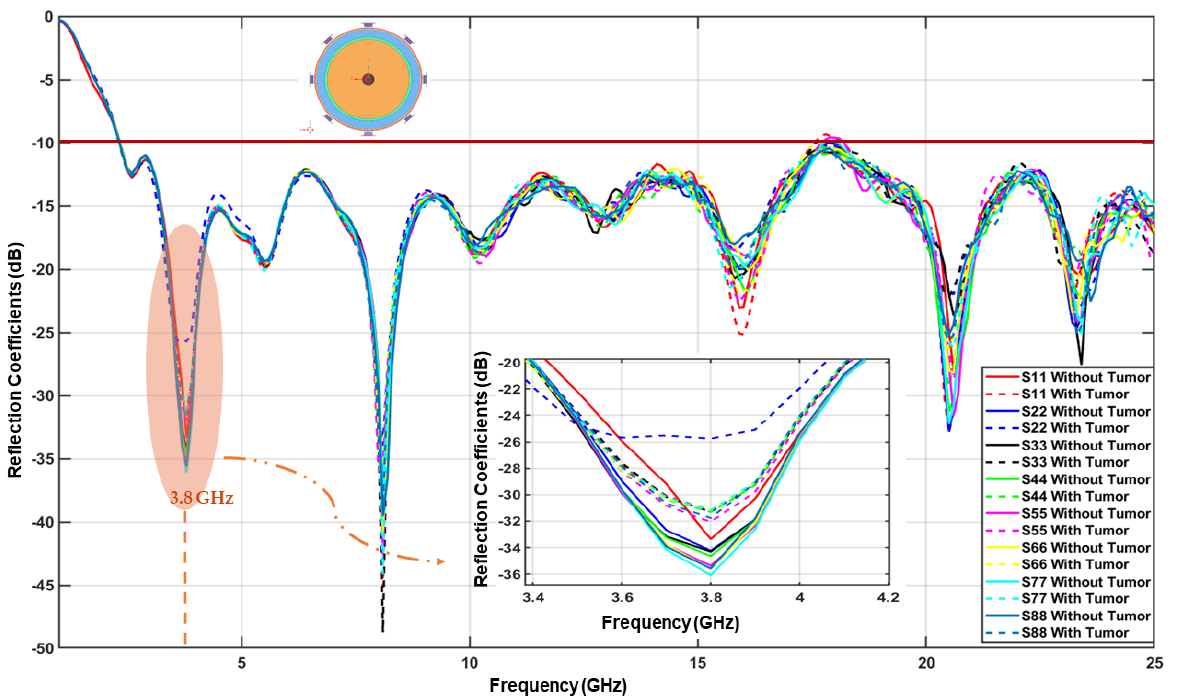
Figure 7. Comparison between reflection coefficients of healthy and unhealthy phantoms when a 15 mm radius tumor is placed in the phantom’s center.